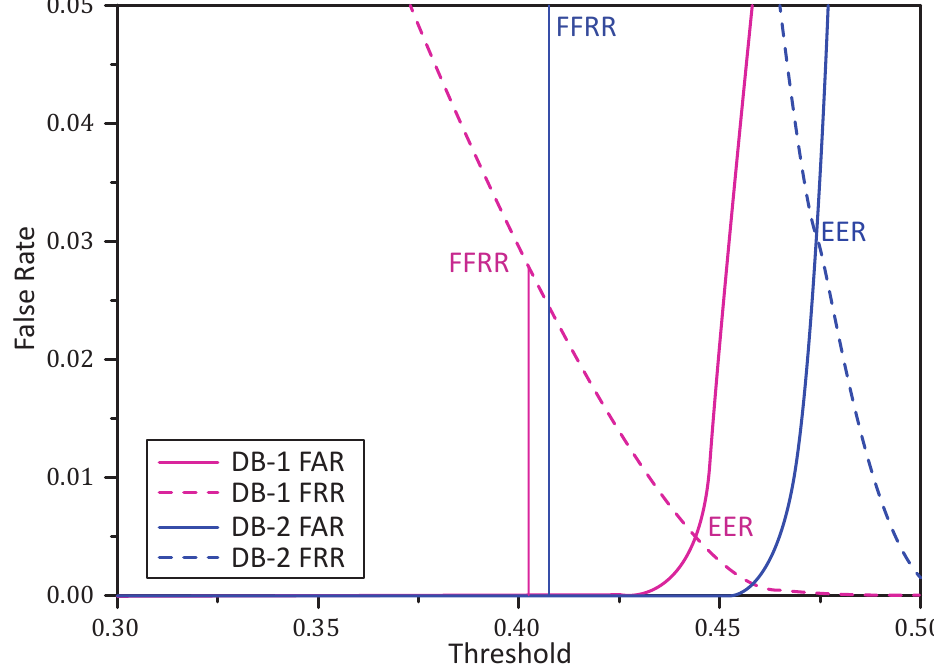
Figure 13. The curves of the false acceptance rate (FAR) and false rejection rate (FRR) against the threshold for DB-1 and DB-2. Only single ROI recognition is carried out here, since it can better reflect the performance of our matching